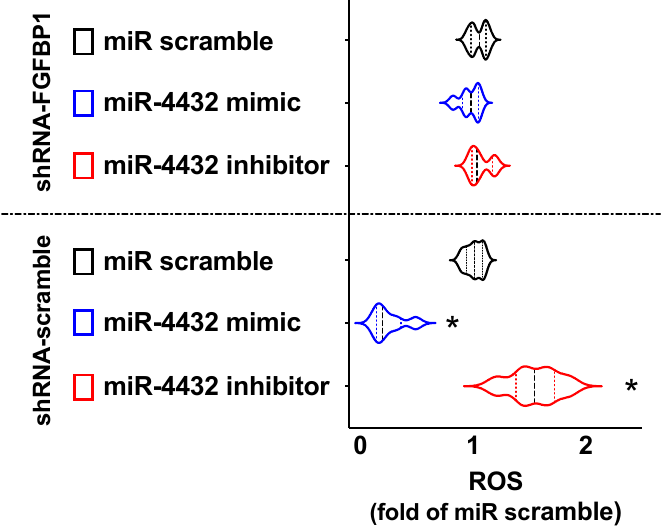
Figure 8. Mitochondrial ROS generation induced by Ang II in hBMECs was not affected when measured after having silenced FGFBP1 (top), whereas it was significantly blunted by miR-4432 mimic and increased by miR-4432 inhibitor when the cells had been treated with a shRNA scramble. All the assays were carried out at least in triplicate; the violin plots show the median (dashed line) and the quartiles (dotted lines); *: p < 0.01 vs. miR-scramble.